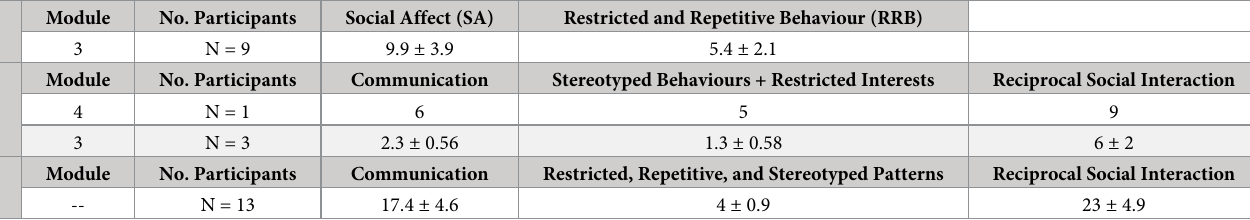
Table 3. Diagnostic information for ASD participants.